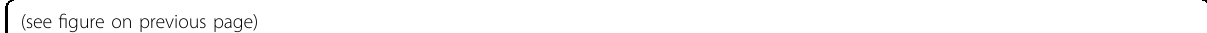
Fig. 7 Neu2 plasmid decreased tumor size through enhancing autophagy and apoptosis in OC xenograft model. A PA1 cells (7 × 10 6 ) in ~200 μ l of PBS:matrigel (1:1) were injected into athymic Balb/c mice ( n = 5) for generating human ovarian cancer xenograft. After tumor sizes reach ~80 – 120 mm 3 , Neu2 plasmid (1.0 μ g/ μ l) was injected intratumorally for 4 times within 15 days as mentioned below. After 15 days of initial plasmid injection, images of all the experimental mice were captured and a representative image of a single mouse from each group is presented, highlighting the differences in tumor size between the two groups. B Tumors from mock and Neu2-plasmid-injected mice were isolated after 15 days of initial injection and representative images from both groups are shown . C In one group of human ovarian cancer xenograft mice ( n = 5), 20 and 60 µg of Neu2 plasmid were injected intratumorally on days 1 and 5 and days 8 and 12, respectively. Concentration of plasmid injections given throughout the experiment and time points were mentioned on the x -axis and indicated with blue arrows. The tumor ’ s size ( y -axis) was measured on days 1, 5, 10, 13, and 15 using a screw gauge and represented on the x -axis of the line graph. D , E Primary cells were isolated from these tumors and protein levels of Neu2 (D) and Atg5 (E) were analyzed by western blot; β -actin was used as the loading control. Representative blots are presented here. F Co-immunoprecipitation analysis of these proteins showed the enhanced association of Atg5 with Neu2 in Neu2-plasmid-injected tumors compared to mock. Representative blots are presented here. G Primary cells from these tumors were stained with autophagy-speci fi c dye and analyzed by FACS. Mock cells MFI value was considered as 100% and Neu2-plasmid cells MFI was compared on bar graph. H These cells were also probed with PI and processed similarly. The results are represented as mean ± SD from independent experiments and p values (* p < 0.05; ** p < 0.01; *** p < 0.001; two-tailed t test) represented the signi fi cant differences between the means of the two test groups. I Schematic diagram outlining the overexpressed Neu2 and sialidase-induced desialylation of Atg5 at α 2,6 linkage leading to its activation to form increased Atg5-Atg12-Atg16L1 complex, which produced more autophagosomes. Neu2 induced enhanced autophagy ultimately promotes anoikis/apoptosis. Neu2 overexpression also inhibits the PI3K-Akt/mTOR pathway, responsible for such apoptosis in OC